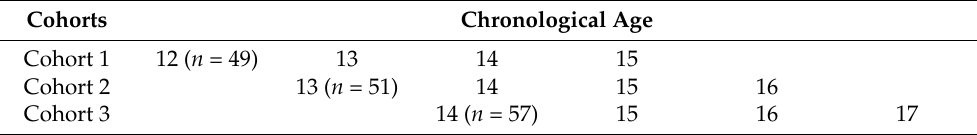
Table 1. Chronological age across cohorts, number of players per cohort (at baseline) and years